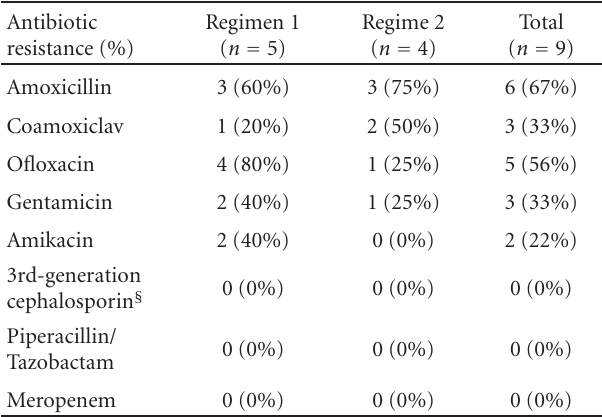
Table 2: Antibiotic resistance for E. coli isolated in blood cultures.